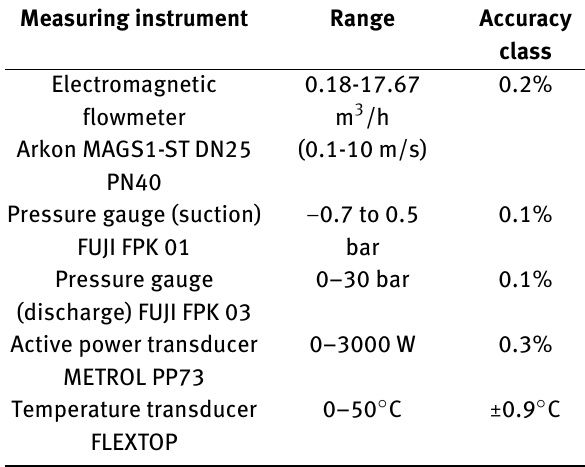
Table 1: Measuring